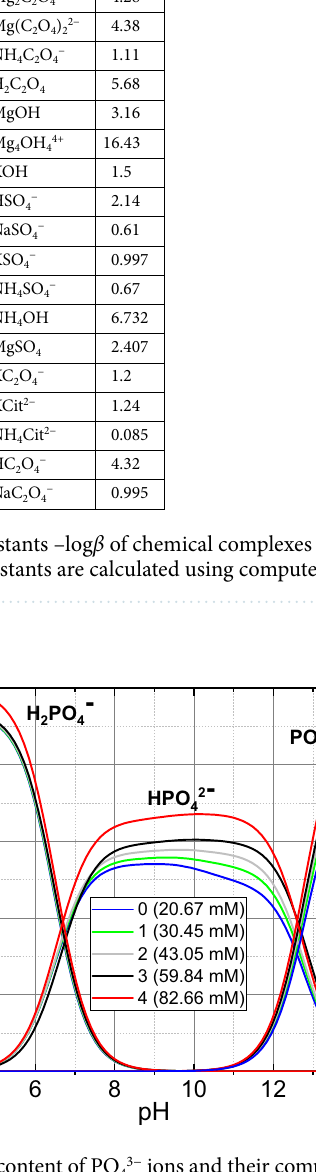
Figure 6. Percentage content of PO 43− ions and their complexes (HPO 42− and H 2 PO 4− ) depending on pH of the artificial urine for different concentrations of P given in the